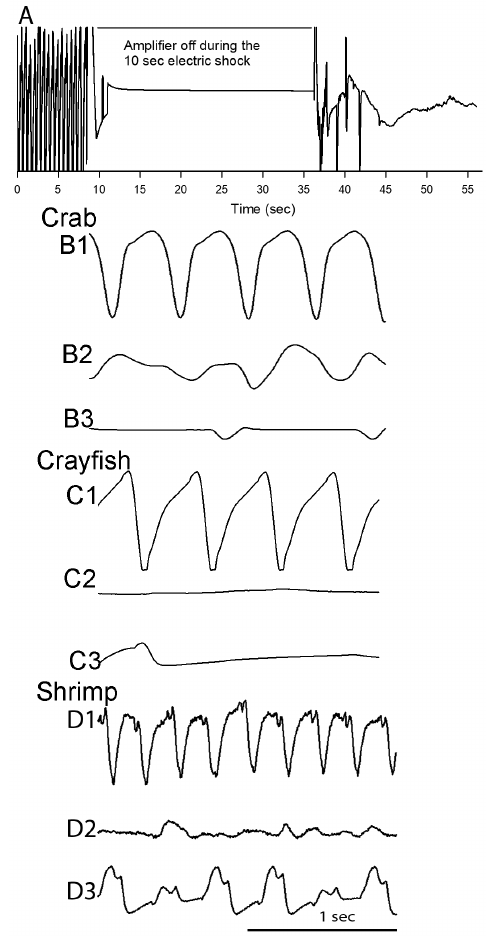
Figure 6. ECG traces before and immediately after electric stunning as well as after 2 to 3 min after electric stunning. ( A ) An ECG trace for a representative crayfish before and after the electric shock indicates the large change that occurs right after the shocking is over. ( B1 ) Crab, ( C1 ) crayfish, and ( D1 ) Belize shrimp had pronounced rhythmic rates prior to electric stimulation. Arrhythmia or no measurable rate occurred immediately after electric stunning for crab ( B2 ), crayfish ( C2 ), and Belize shrimp ( D2 ). In some cases, the arrhythmic rate persisted, and all animals showed an altered amplitude and shape in the ECG traces after electric stunning (crab, ( B3 ); crayfish, ( C3 ); Belize shrimp, ( D3 )). The traces shown are from the same animals during the different time periods. The 1 s scale bar applies to all traces.